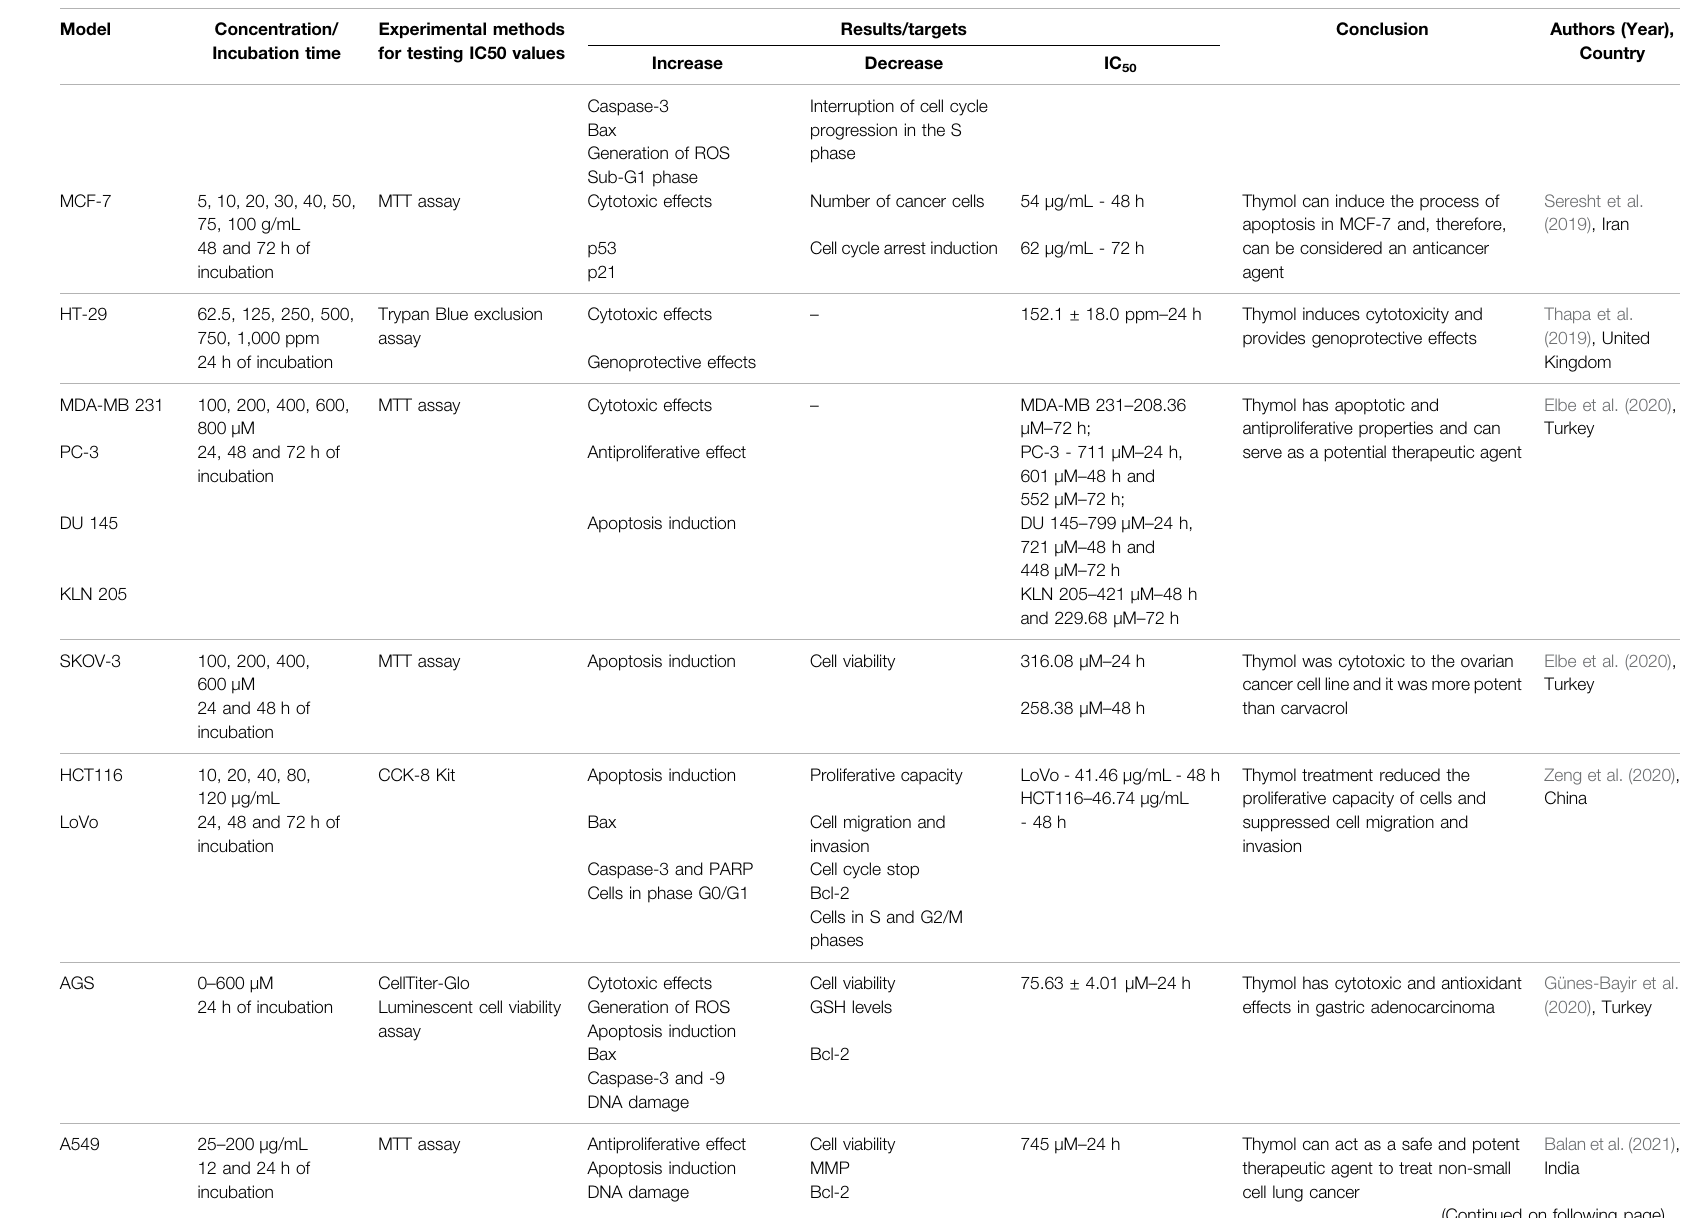
TABLE 2 | ( Continued ) Detailed description of the studies that used thymol, included in the systematic